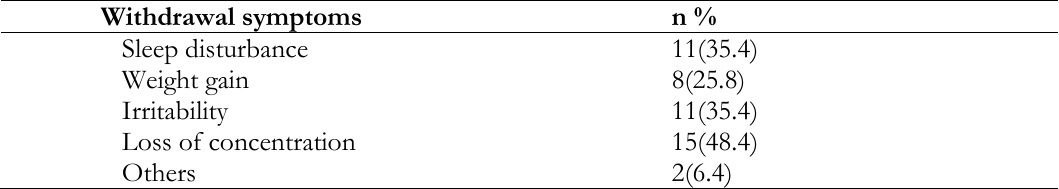
Table IV. Numbers of participants reporting withdrawal symptoms of